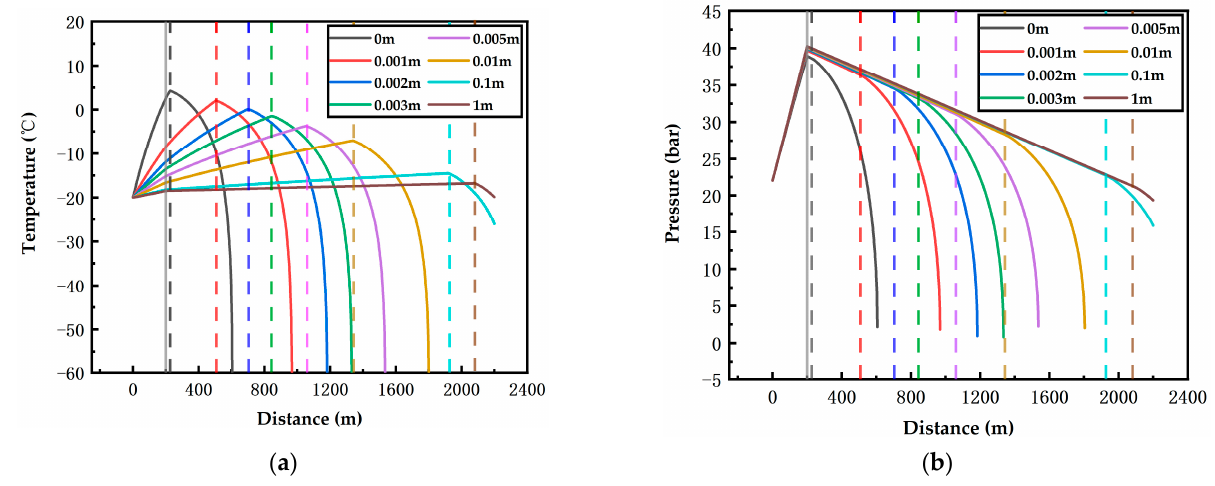
Figure 15. Effects of pipelines with different insulation thicknesses on the temperature ( a ) and pressure ( b ) of CO 2 along the pipeline at 15 m/s airflow velocity, 40 °C ambient temperature and 200 m depth (Grey solid line: the connection position of the vertical pipeline and the underground horizontal pipeline; colorful dotted lines: the gasification starting positions).